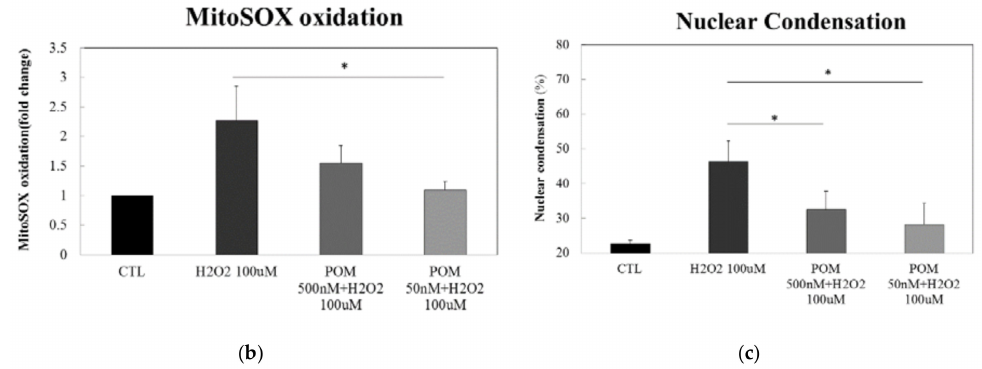
Figure 3. Detection of mitochondrial-specific superoxide in H 2 O 2 -induced oxidative stress. Cells were pretreated with POM for 24 h then exposed to 100 µ M H 2 O 2 for 0.5 h. Subsequently, ( a ) cells were labeled with mitochondrial-specific superoxide, detected using fluorogenic MitoSOX™ dye (red fluorescence, 1st panel), Hoechst 33342 (blue fluorescence, 2nd panel); merged (3rd panel) at 200 × (magnification). ( b ) The fluorescence intensity fold change of MitoSOX™. The fluorescence intensity was quantified and normalized to the number of cells. Data are presented as the fold change relative to the control (CTL) group. ( c ) The nuclear condensation of Hoechst 33342, histogram showing the percentage of apoptotic cells (featured by nuclear condensation) in the cell population. Comparing the control group (CTL) to the H 2 O 2 alone challenged group, both the Hoechst 33342 stain and MitoSOX™ Red stain are significantly different ( p < 0.05). Notably, POM significantly mitigated H 2 O 2 -induced changes, with * p < 0.05 versus the 100 µ M H 2 O 2 alone challenged group. Data are representative of three independent experiments. Bars represent mean values ± SEM ( n =